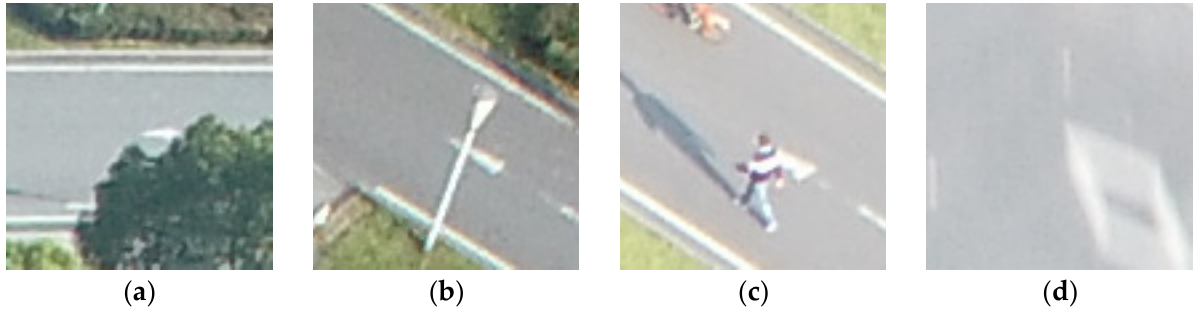
Figure 3. Four typical cases of low-quality ROIs: A tree canopy ( a ), a lamp post ( b ), and a pedestrian ( c ) block targets, respectively; ( d ) poor imaging due to the rapid turning of the drone.